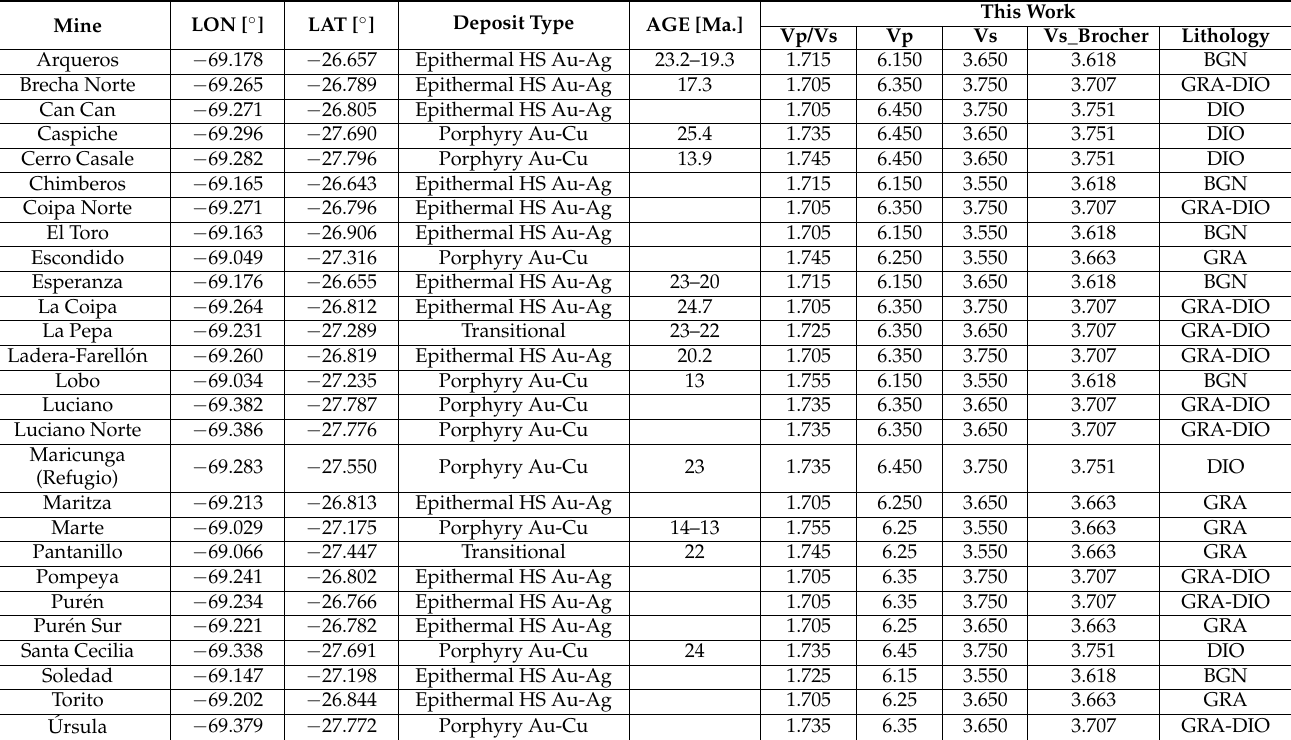
− 69.049 − 27.316 − 69.264 − 26.812 − 69.231 −